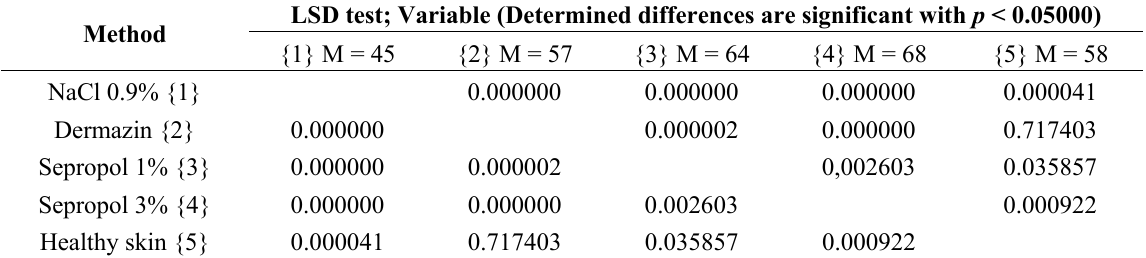
Table 3. p values showing significance levels for subsequent mean